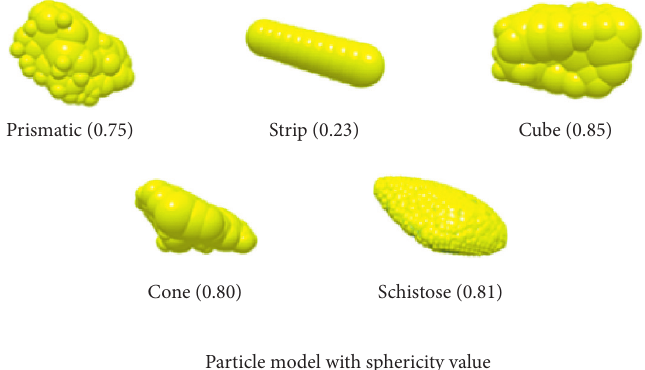
Figure 6: Coarse aggregate particle model.